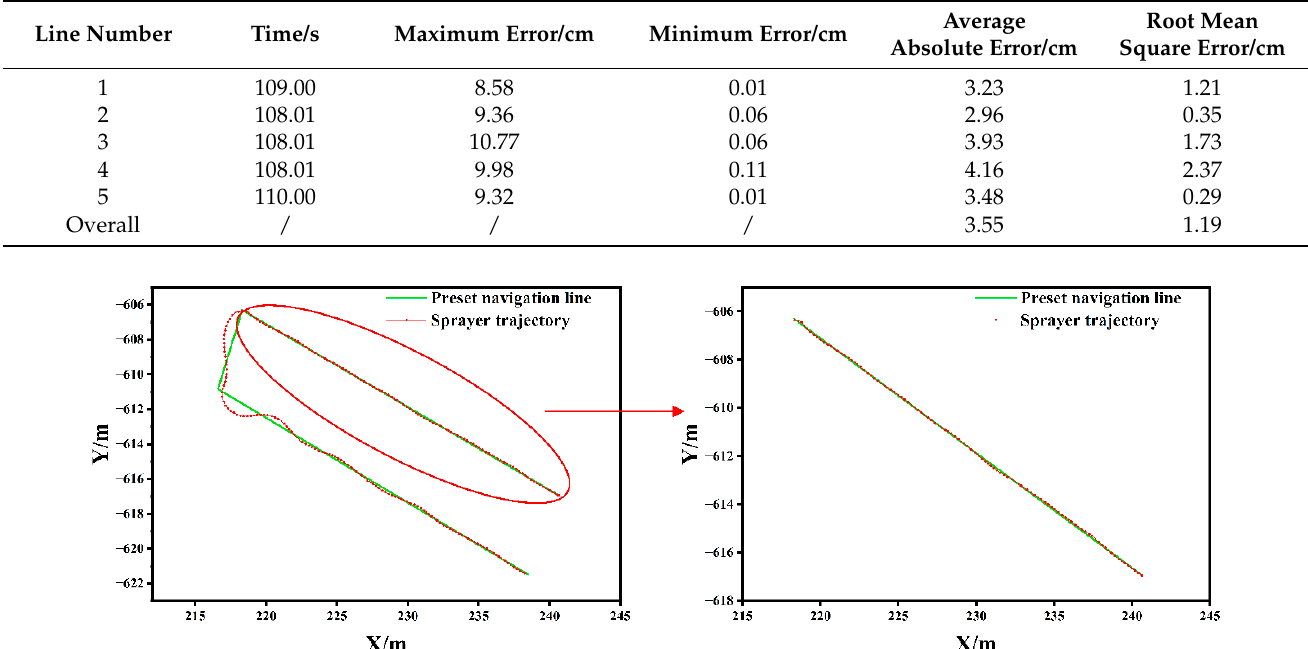
Table 1. The results of the navigation experiments in the citrus orchard.